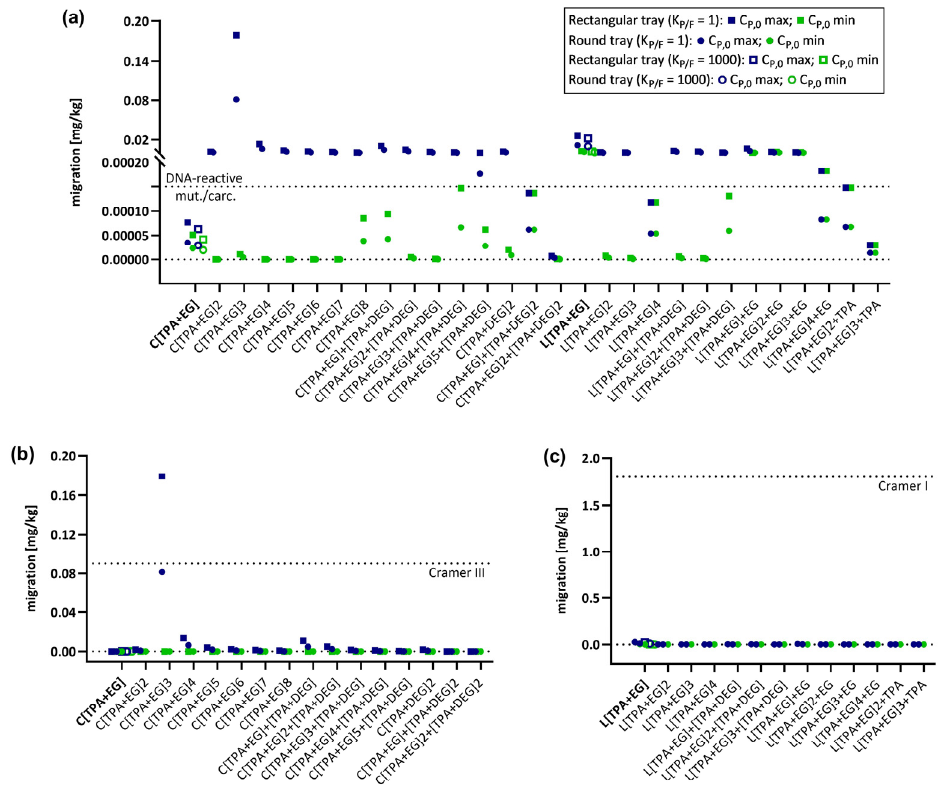
Figure 1. Graphical representation of predicted migrations using the activation energy E A -based model. Migration of PET oligomers for which C P,0 values were available was predicted for PET trays (rectangular and round) under long-term heating conditions (100 ◦ C, 2 h) and evaluated for exceeding different safety thresholds. Oligomer names in bold represent molecules for which both K P/F = 1 and K P/F = 1000 were used for predictions. ( a ) Modeled migration of all 29 PET oligomers and their evaluation against the DNA-reactive mutagens/carcinogens safety threshold of 0.15 µ g/kg. ( b ) Modeled migration of cyclic PET oligomers and their evaluation against the Cramer Class III threshold of 90 µ g/kg. ( c ) Modeled migration of linear PET oligomers and their evaluation against the Cramer Class I threshold of 1.8 mg/kg.